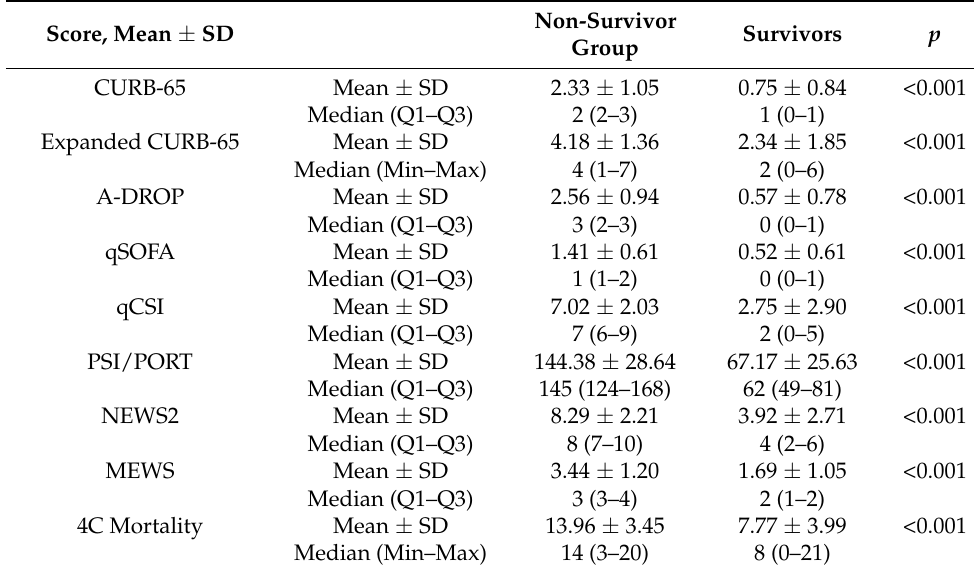
Table 3. Prognostic scores of patients.